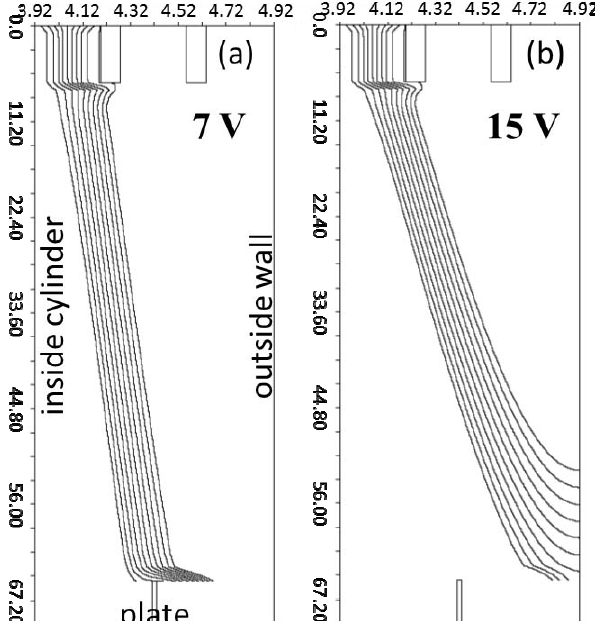
Fig. 7 Calculated 120 nm-particle trajectories in the apparatus at the flow rate of 300 mL/min and the applied voltage of: (a) 7 V; (b)15V.